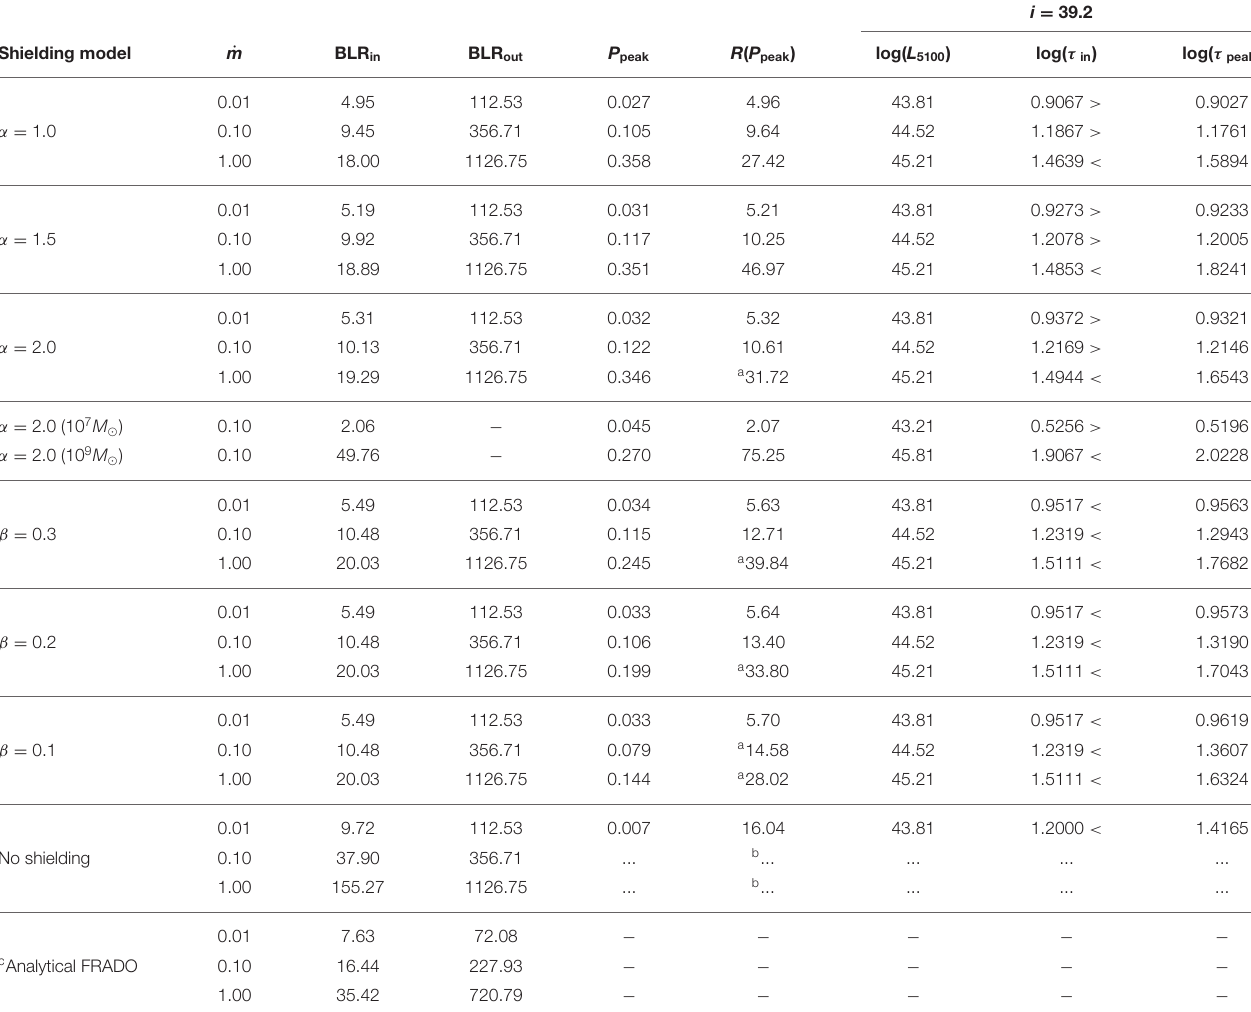
TABLE 1 | Output data for the size of BLR for blackhole mass of 10 8 M ⊙